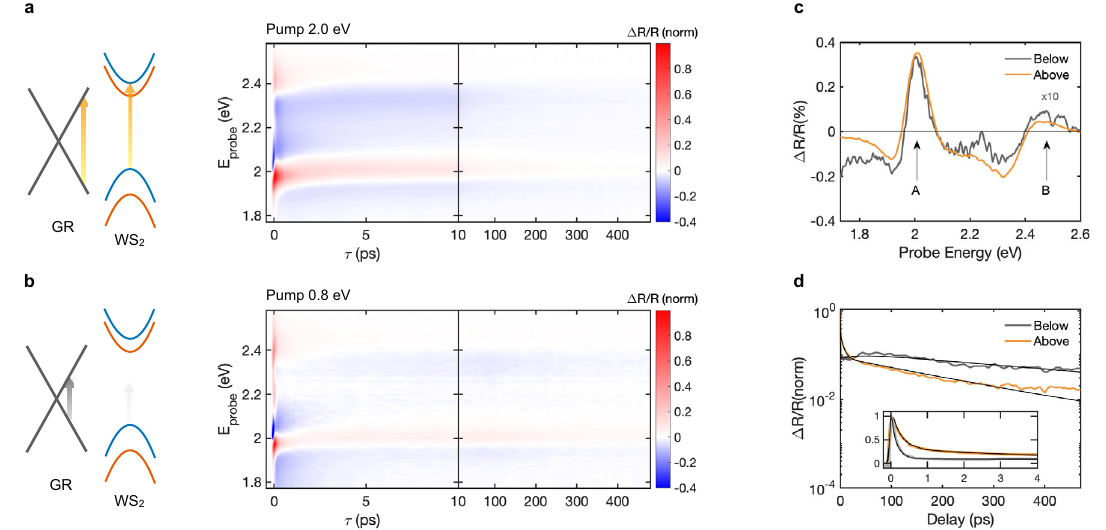
Fig. 2 Transient optical response of WS 2 /graphene HS excited above and below the optical gap of 1L-WS 2 . Normalized Δ R / R map of WS 2 / graphene HS measured upon a above-gap ( E pump = 2.0 eV, fl uence ~ 28 μ J/cm 2 ) and b below-gap photoexcitation ( E pump = 0.8 eV, fl uence ~ 61 μ J/cm 2 ). c Δ R / R spectra at τ = 1 ps for above (orange) and below (grey) gap excitation. In both the photoexcitation regimes Δ R / R spectra are dominated by the bleaching of the A/B excitons. d Normalized dynamics of the HS measured at the A excitonic resonance for both excitation regimes. In the inset a zoom in 0-4 ps delay. The black curves are the multi-exponential fi ts to the data. On a short timescale, for above-gap excitation (yellow), the trace decays on a timescale of τ 1 = 297 ± 24 fs and τ 2 = 11.9 ± 2.3 ps while, for below-gap excitation, τ 1 = 135 ± 22 fs and τ 2 = 40.5 ± 6.4 ps. On a longer timescale the traces display an additional slower decay component τ 3 = 270 ± 196 ps (above gap) and τ 3 = 704 ± 291 ps (below